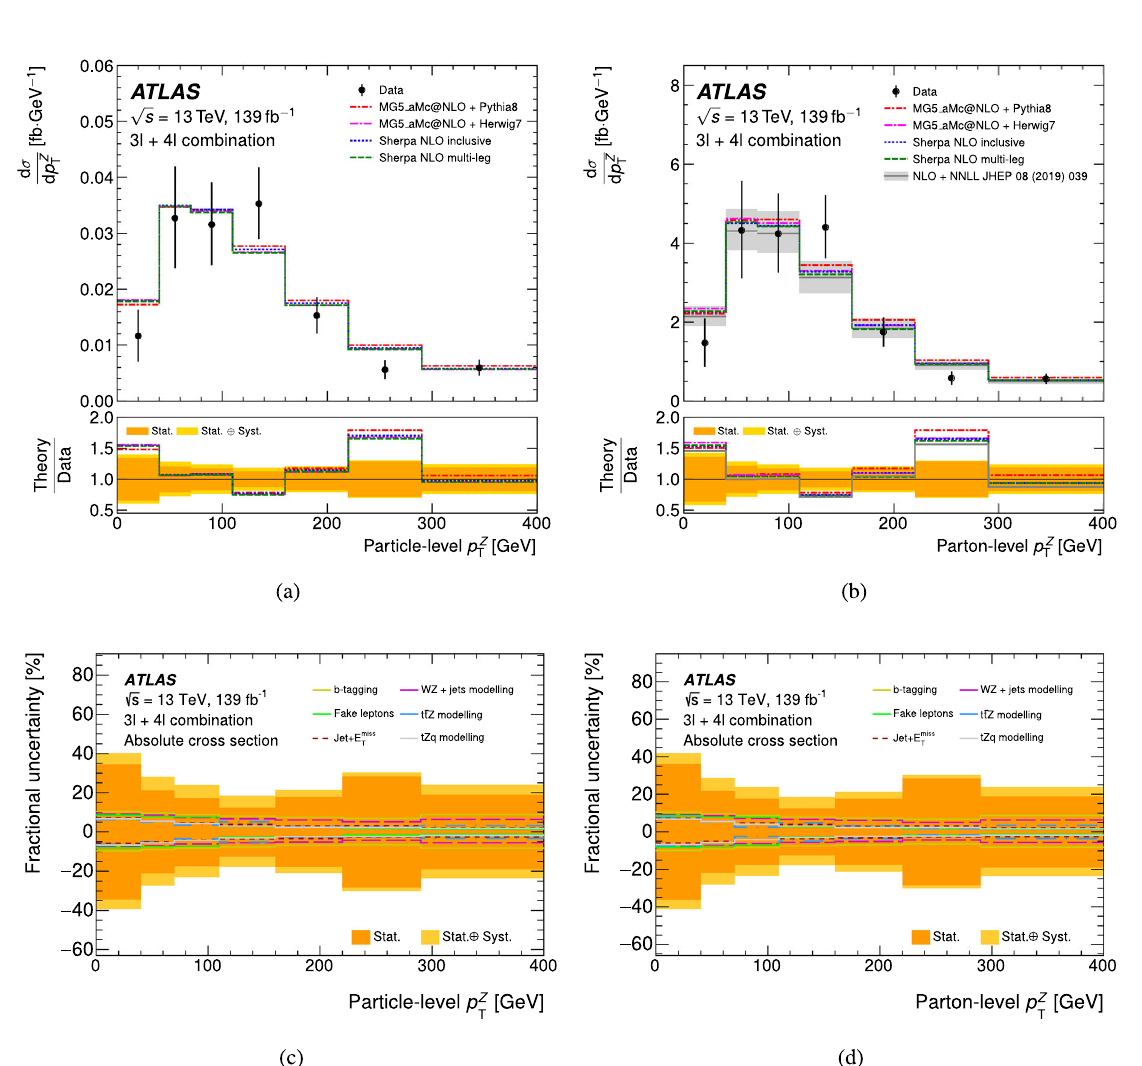
Fig. 9 Absolute differential t ¯ tZ cross sections measured at a particle level and b parton level as a function of the transverse momentum of the reconstructed Z boson. c , d Show the relative contributions from differ- ent categories of systematic uncertainties per bin. The large difference between the y -axis scales in a and b is a result of different efficiency